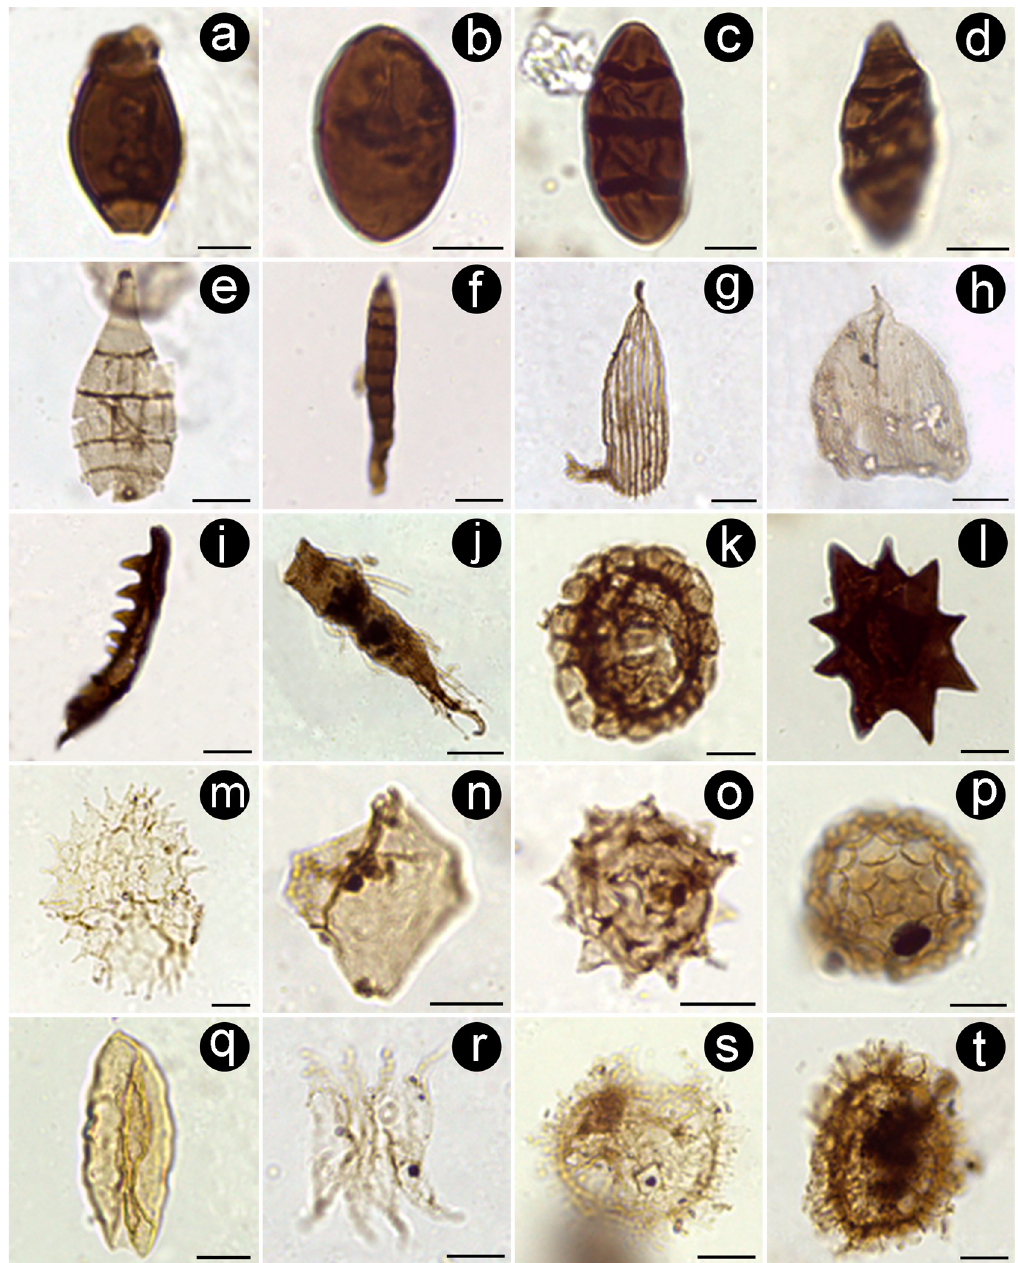
Fig 7. Microscope images of selected non-pollen palynomorphs from Casa Grande Formation. (A) Biporipsilonites krempii (PAL JUA (P) Cz/Plg. N˚ 001b(Eo)+10 μ m: 2–142.5). (B) Inapertisporitese edigeri (PAL JUA (P) Cz/Plg. N˚ 001b(Eo)+10 μ m: 6–145.5). (C) Multicellites crassisporus (PAL JUA (P) Cz/Plg. N˚ 001d(Eo)+10 μ m: 20.8–129.2). (D) Quilonia cf. Q . allepeyensi (PAL JUA (P) Cz/Plg. N˚ 001b(Eo)+10 μ m: 4.1–126.7). (E) Polycellaesporonites bellus (PAL JUA (P) Cz/Plg. N˚ 001e(Eo) +10 μ m: 7–141.5). (F) Scolecosporites modicus (PAL JUA (P) Cz/Plg. N˚ 001b(Eo)+10 μ m: 7.5–153.4). (G) Scales of Lepidopteran wings (PAL JUA (P) Cz/Plg. N˚ 001e(Eo)+25 μ m: 11–143.9). (H) Scales of Lepidopteran wings (PAL JUA (P) Cz/ Plg. N˚ 001d(Eo)+25 μ m: 19.8–141.5). (I) Scolecodont-like palynomorph (PAL JUA (P) Cz/Plg. N˚ 001e(Eo)+25 μ m: 2–153.9). (J) Hydrozetes adult leg (PAL JUA (P) Cz/Plg. N˚ 001d(Eo)+25 μ m: 16.5–144.5). (K) Filinia -type resting eggs (PAL JUA (P) Cz/ Plg. N˚ 001d(Eo)+25 μ m: 23.2–155). (L) Compact type sclerocyte (PAL JUA (P) Cz/Plg. N˚ 001d(Eo)+25 μ m: 22.5–152). (M) Pediastrum boryanum (PAL JUA (P) Cz/Plg. N˚ 001d(Eo)+25 μ m: 4–149.5). (N) Mougeotia sp. (PAL JUA (P) Cz/Plg. N˚ 001a (Eo)+10 μ m: 6–145). (O) Planctonites stellarius (PAL JUA (P) Cz/Plg. N˚ 001d(Eo)+10 μ m: 18–145). (P) Stigmozygodites ministigmosus (PAL JUA (P) Cz/Plg. N˚ 001d(Eo)+25 μ m: 8.8–138). (Q) Spirogyra sp. 6 Martı´nez et al. 2008 (PAL JUA (P) Cz/ Plg. N˚ 001d(Eo)+10 μ m: 23.9–134.9). (R) Scenedesmus sp. (PAL JUA (P) Cz/Plg. N˚ 001e(Eo)+25 μ m: 3.5–147.5).